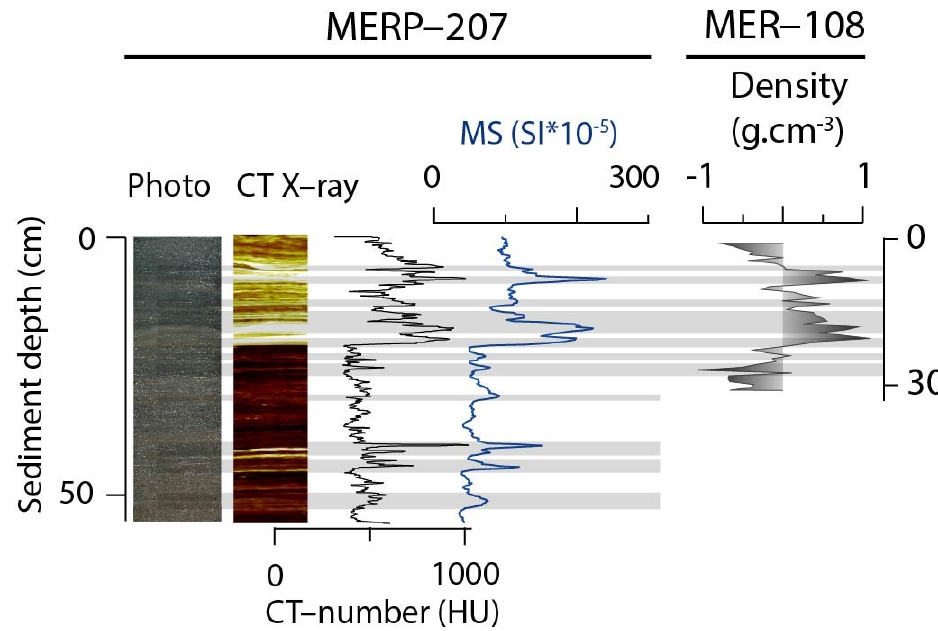
Figure 6. Flood deposits in the organic-rich Lake Meringsdalsvatnet (MER) sedimentary sequence.